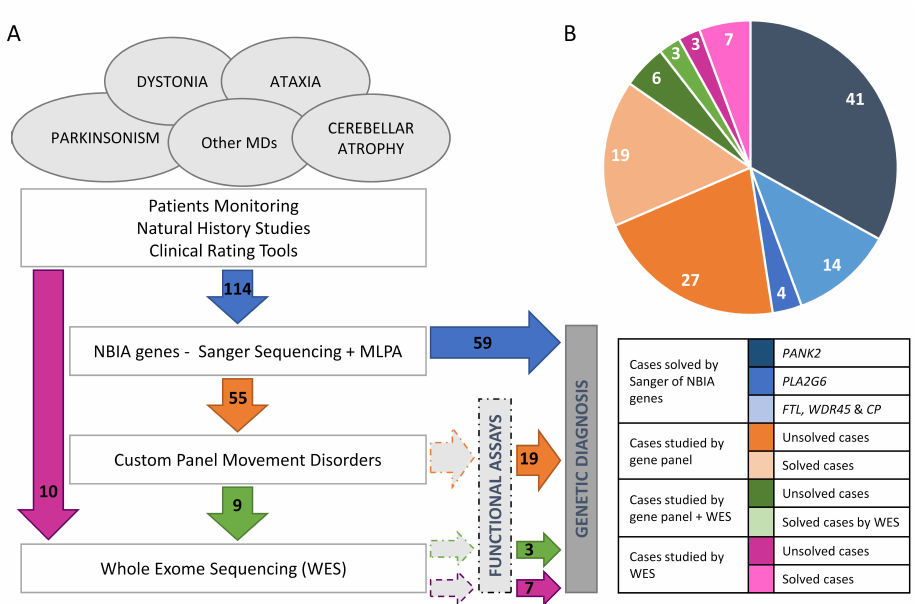
Figure 1. Casuistry and strategy. ( A ) Pipeline designed for genetic analysis of a cohort of patients with movement disorders and ataxia, which includes different approaches from candidate gene to gene panel and WES (whole exome sequencing) carried out in a cohort of 124 probands. ( B ) Distribution of cases studied by gene panel MovDisord. In 59 probands, a definitive diagnosis was achieved by Sanger sequencing and MLPA (in blue): 41 patients carried mutations in PANK2 , 14 in PLA2G6 , and 4 in other NBIA genes (http://espinos.cipf.es/index.php/en/mutations-db, accessed on 1 August 2022). Using a custom panel MovDisord, the remaining 55 probands were investigated and the causative mutations were identified in 19 cases (in orange). Finally, nine patients were further studied by WES and in three cases the clinical variant was detected (in green). To compare both approaches (gene panel versus WES), ten patients were investigated by WES only, and the disease-causing mutations were detected in seven of them (in purple). NBIA: neurodegeneration with brain iron accumulation. MD: Movement disorders. MLPA: multiplex ligation-dependent probe